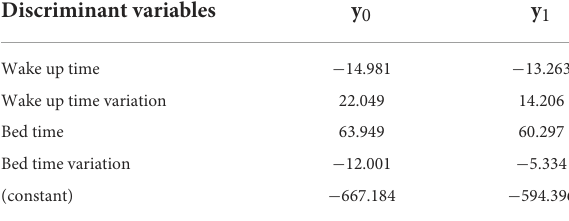
TABLE 7 Fisher function coefficients of 15–18 months age group.